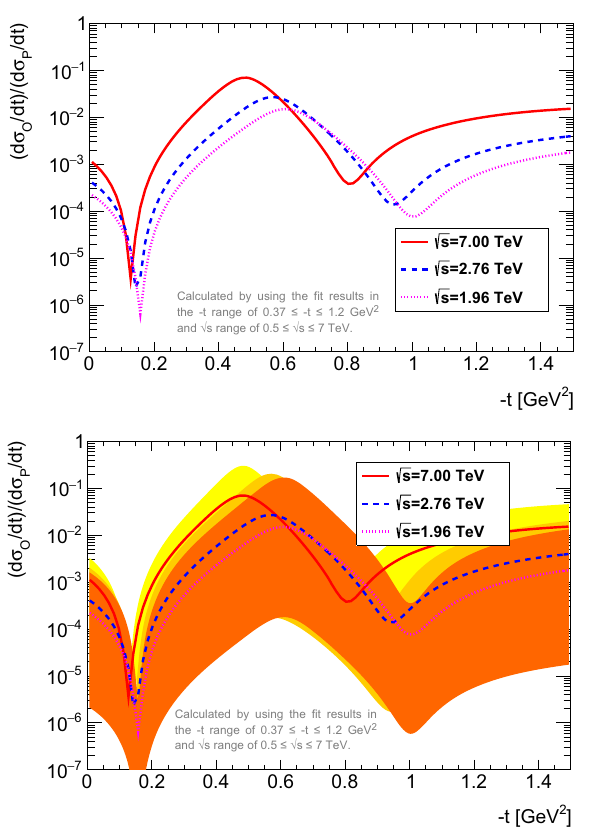
Fig. 24 SameasFig.21,butforthephaseoftheamplitudeofPomeron